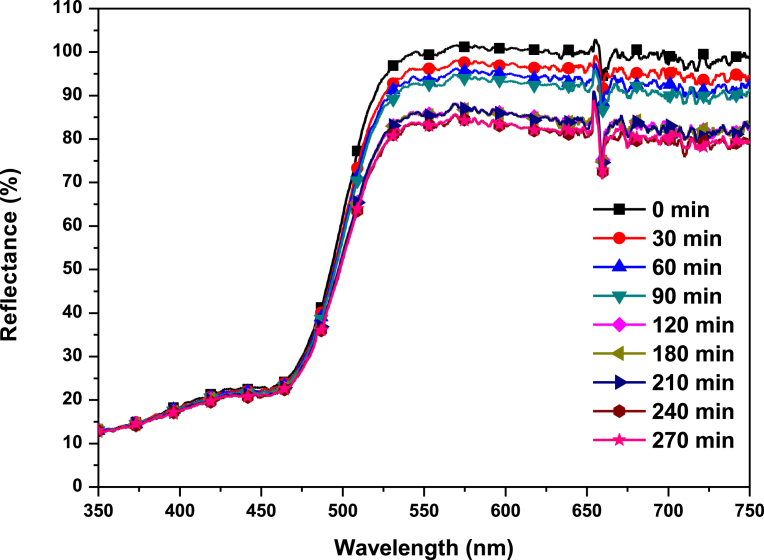
Diffuse Reflectance of Ag3PO4 under UV- visible light irradiation.